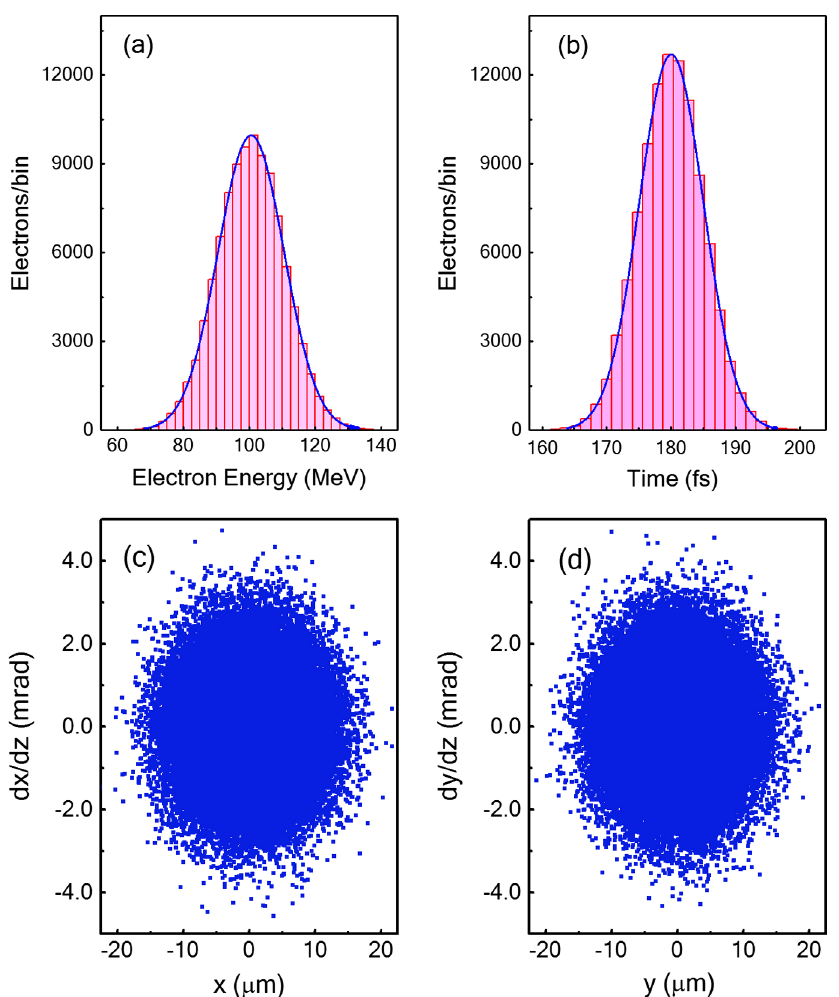
FIG. 2. Electron beam phase space, as generated by a normal random number generator. Electron beam energy spectrum (a), electron beam temporal profile (b), and transverse electron beam phase space plots (c), (d). The energy spread of the electron beam (FWHM) is 24%. The electron beam angular, temporal, and spatial Gaussian profiles have corresponding FWHM widths of 2.4 mrad, 12 femto- second, and 12 microns,